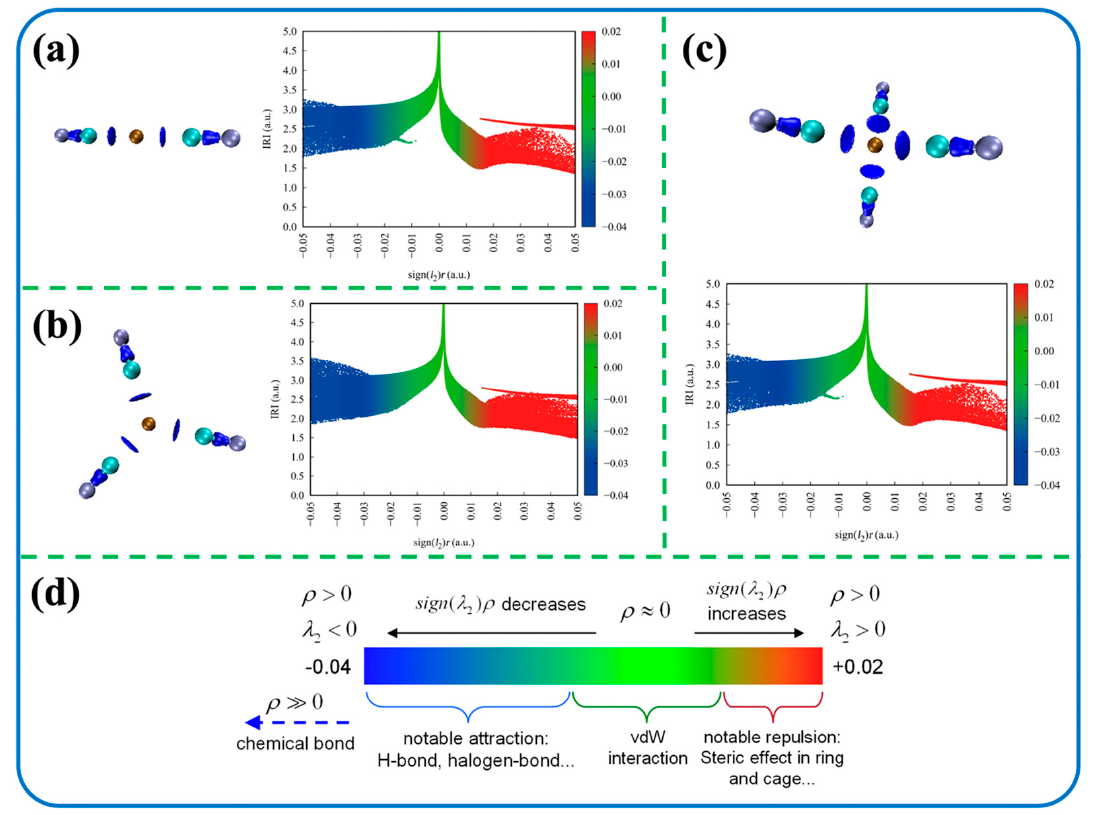
Figure 3. The interaction force structure and scatter diagram of ( a ) Cu(CN) 2 − , ( b ) Cu(CN) 32 − , ( c ) Cu(CN) 43 − and ( d ) coloring method of sign( λ 2 ) ρ .